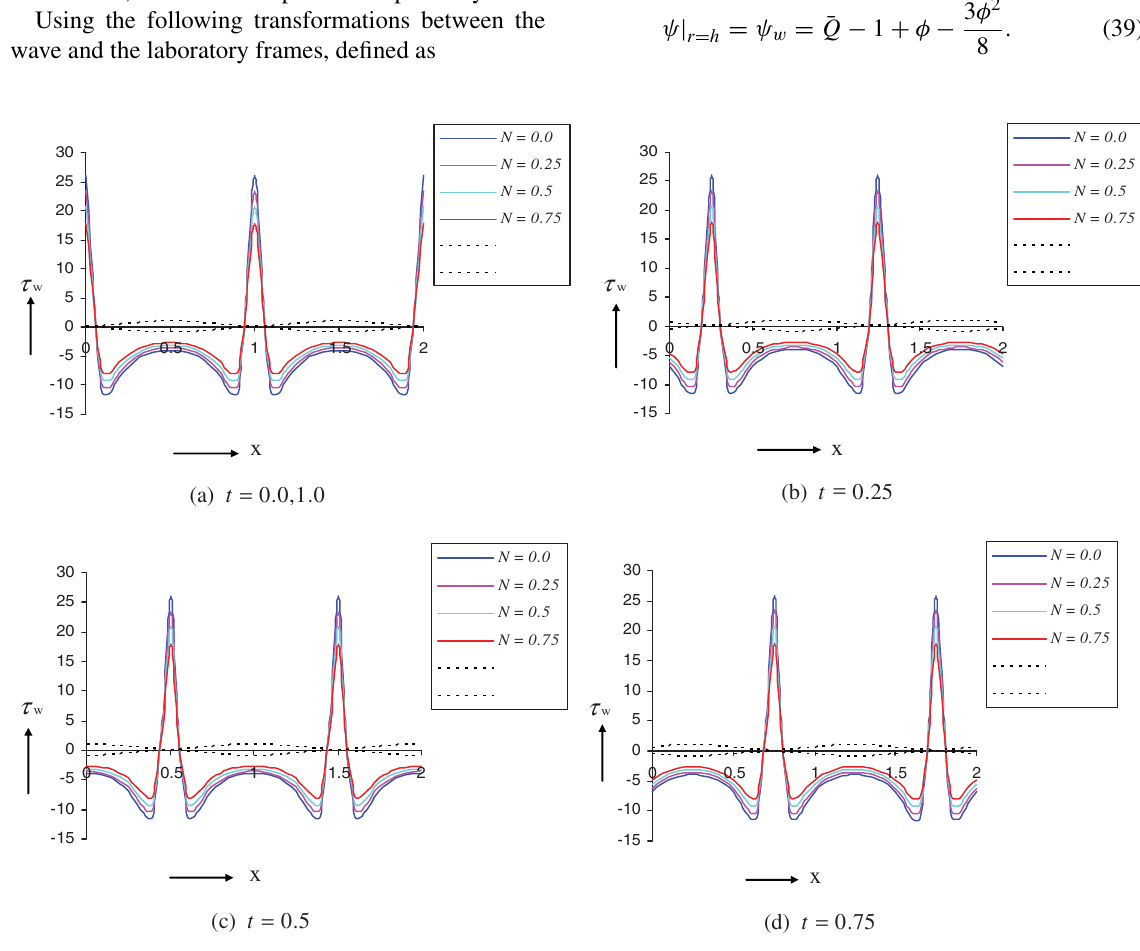
Fig. 6. Local wall shear stress vs. axial distance along the finite length tube at five time instants based on Eq. (32). Dotted lines ( ······ ) represent the position of wave, whereas continuous lines (—) represent the local wall shear stress for N =0.0–1.0, φ =0.9, M =1.0 and l